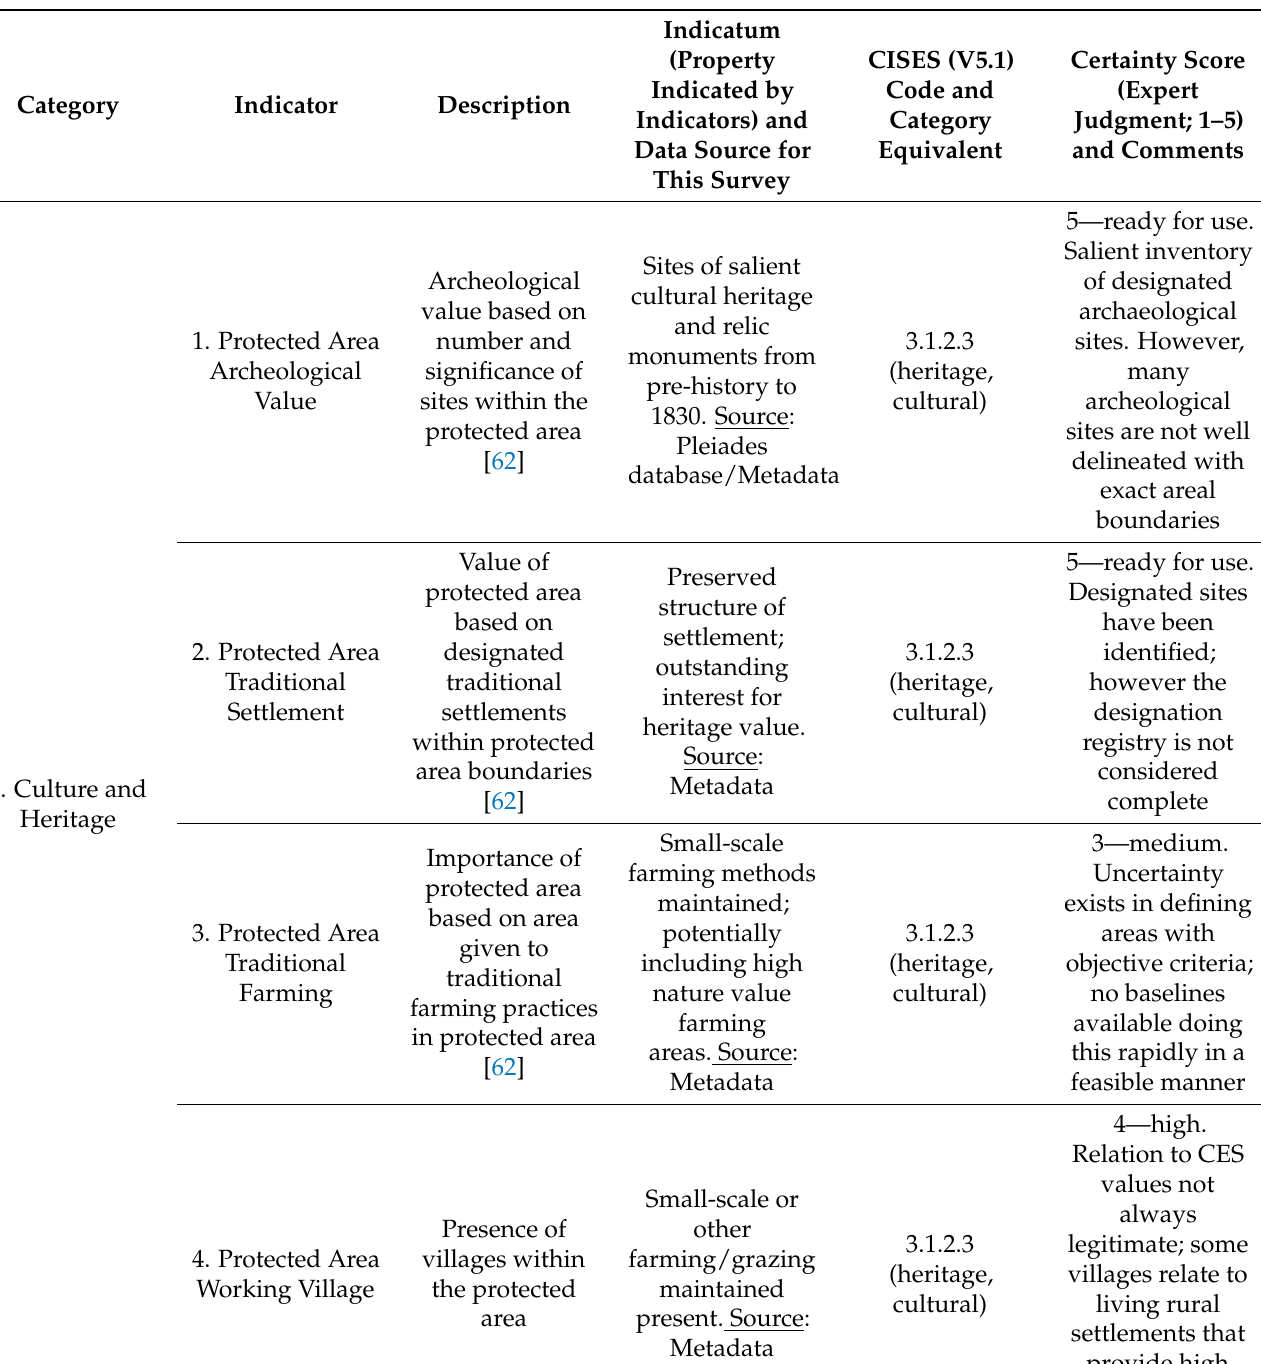
Table 1. List of 22 CES proxy indicators selected in this